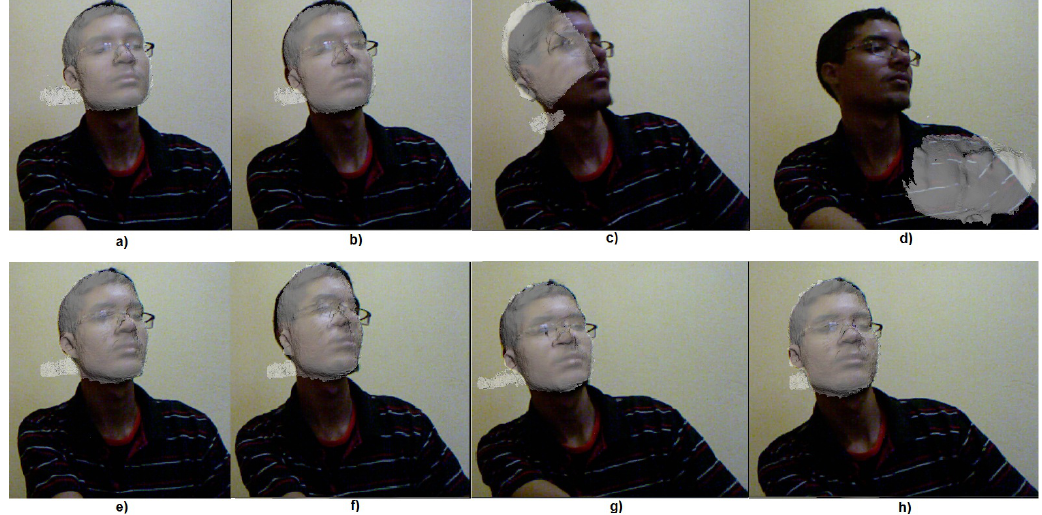
Fig. 4. Tracking with ICP: a) The tracking is started. b) The user moves his face in front of the Kinect and the motion is not totally compensated by the algorithm. c) The ICP fails d) completely. Tracking with ICP + Head Pose Estimation: e) The tracking is started. f) The user moves his face in front of the Kinect and the motion is not totally compensated by the algorithm. g), h) The ICP fails but it recovers with the initial guess provided by the head pose estimation.